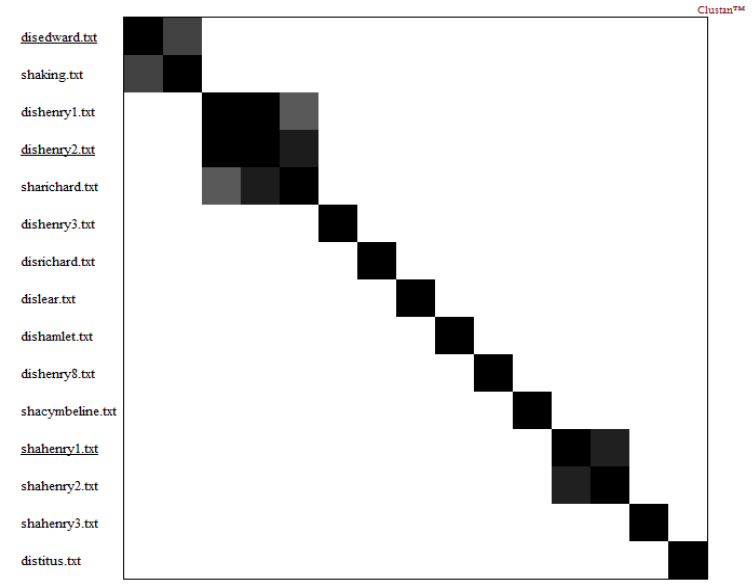
Figure 4. An assessment of clustering tendency test for Shakespeare D FW .